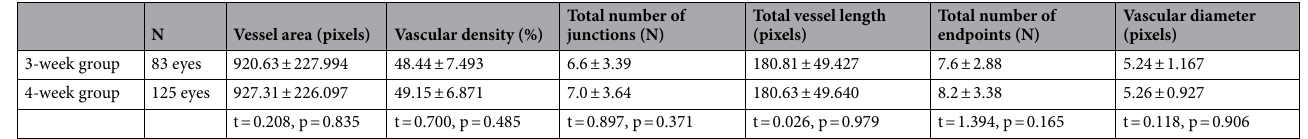
Table 1. Blood flow parameters of the optic disc head based on